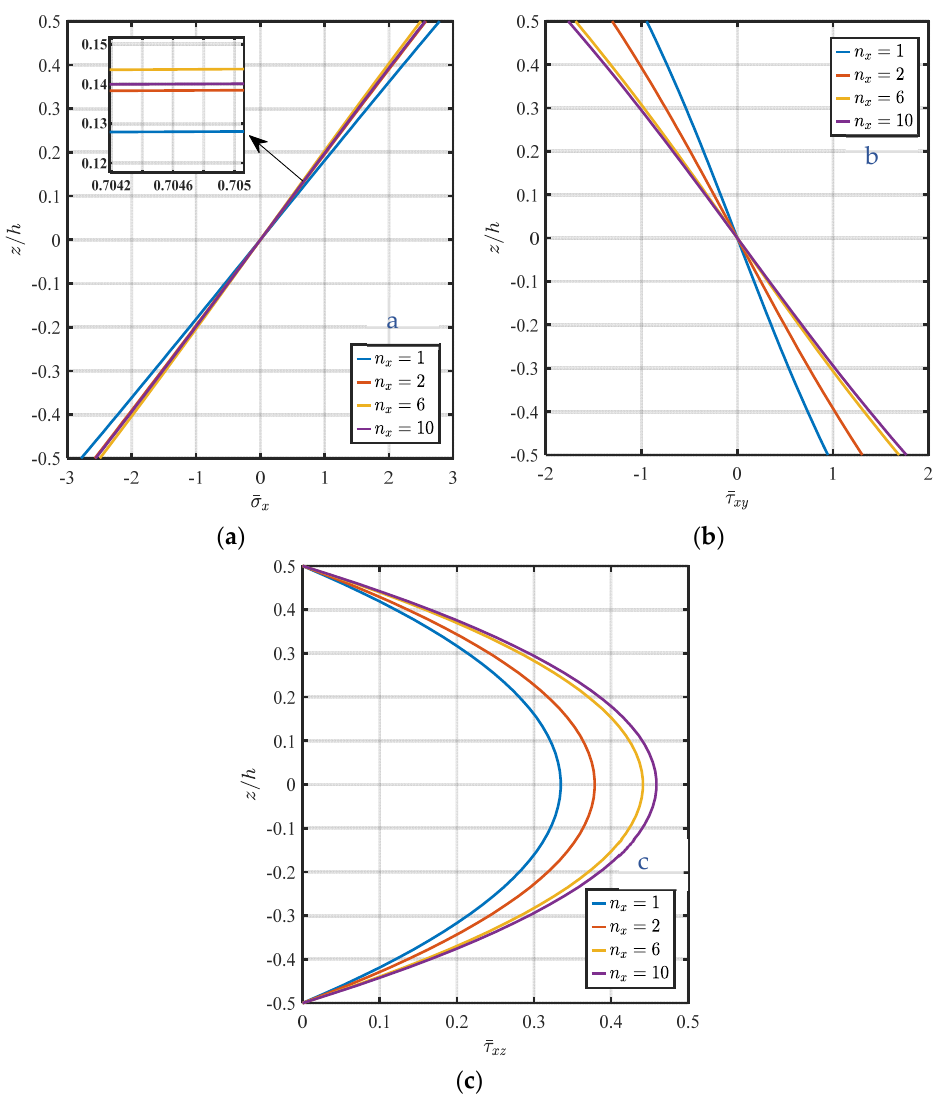
Figure 8. Non-dimensional stresses of ( S im − NS ) BDFG at different n x ( a / h = 10, n z = 0 ) . ( a ) Normal stress σ x . ( b ) Shear stress τ xy . ( c ) Shear stress τ xz